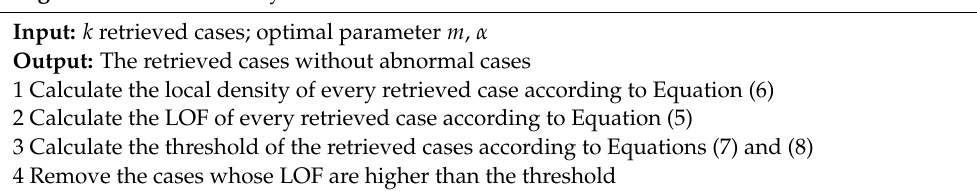
Algorithm 1: Local density-based abnormal case